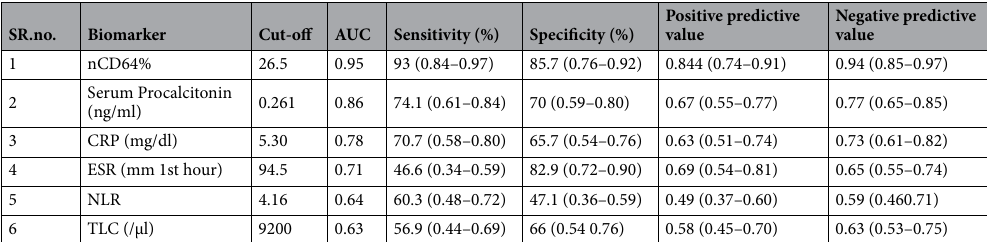
Table 3. Diagnostic accuracy of the various biomarkers (N = 128). Area under curve (AUC) was estimated using ROC curve. p < 0.05 significant. Results are expressed as Estimate (95% Confidence intervals). nCD64% Neutrophils CD64 expression in percentage, CRP C-reactive protein, ESR erythrocyte sedimentation rate, NLR neutrophil: lymphocyte ratio, TLC total leukocyte count.